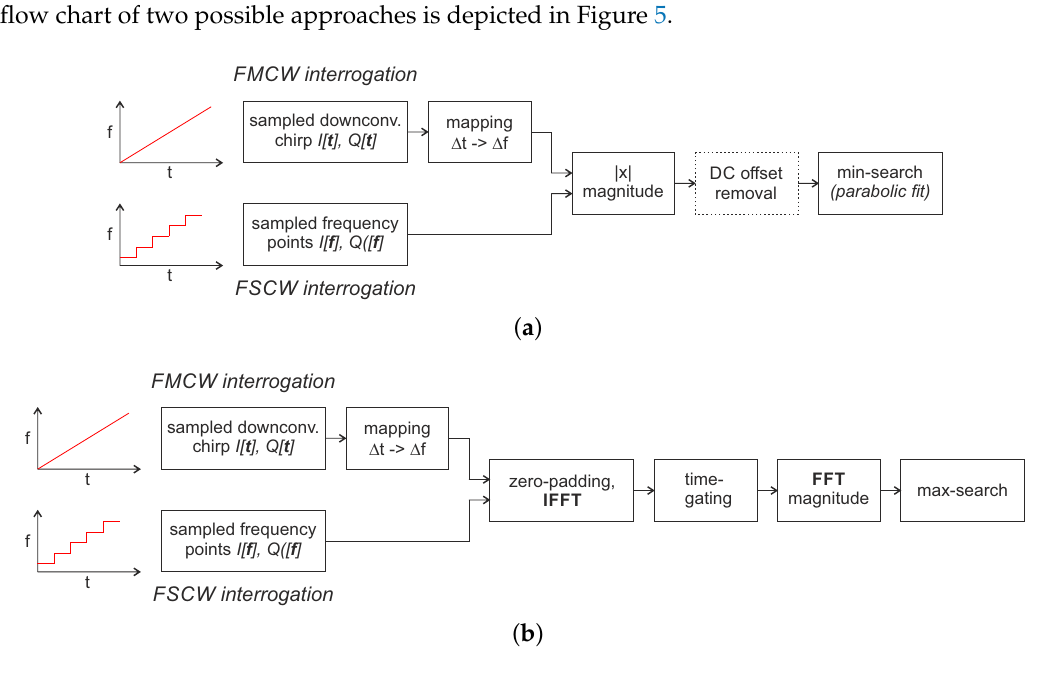
Figure 5. Signal processing flow chart for frequency domain sampling with resonant SAW sensors. ( a ) direct calculation of the resonance frequency from the sampled frequency points; ( b ) calculation of the resonance frequency using additional software time-gating to mask static reflections of the environment as well as mismatches and crosstalk within the front